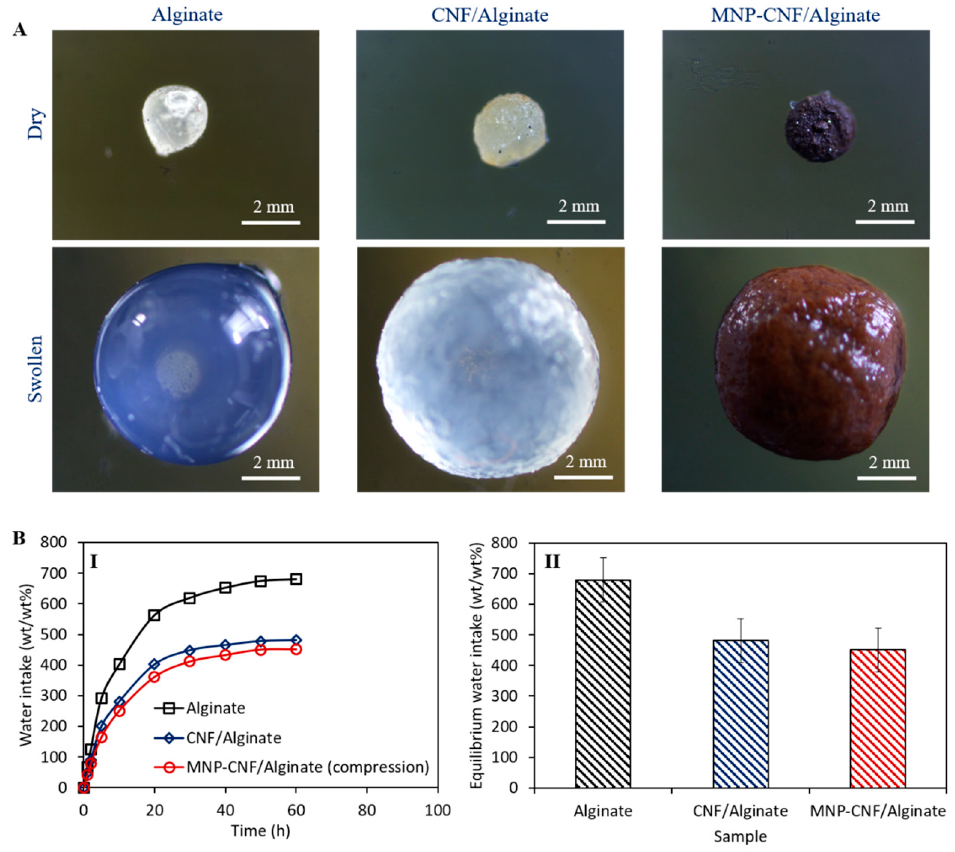
Figure 3. Swelling behaviour of composite gel beads. ( A ) Volume expansion of gel beads while fully swollen. ( B ) Water intake capacity of the gel beads: I . Time-dependent water intake curves and II . Equilibrium water intake after 60 h of swelling tests.